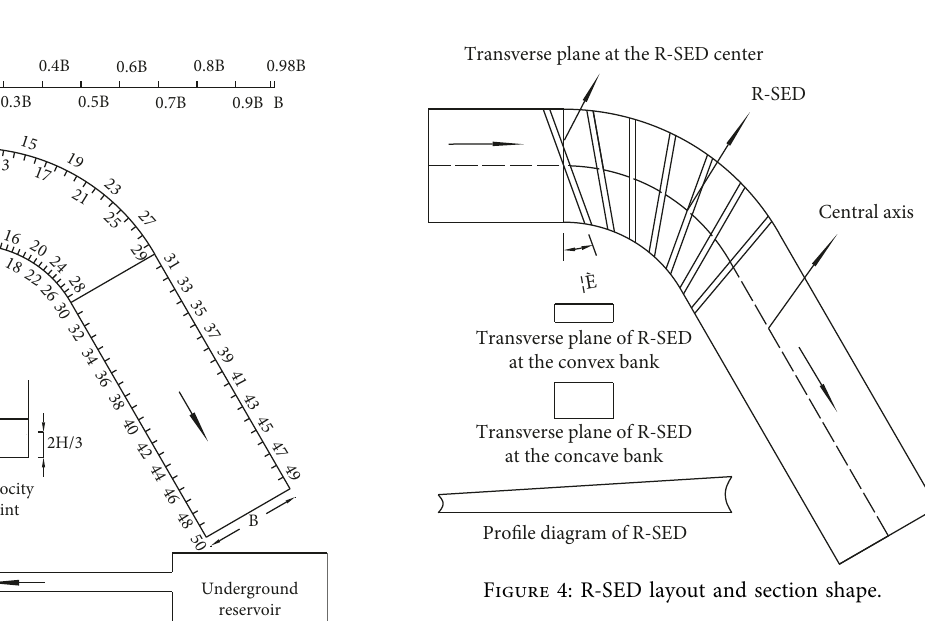
Figure 2: Comparison of flow regime under R-SED conditions and non-R-SED conditions: (a) non-R-SED condition (curved section), (b) R-SED condition (curved section), (c) non-R-SED condition (downstream exit section) and (d) R-SED condition (downstream exit section).